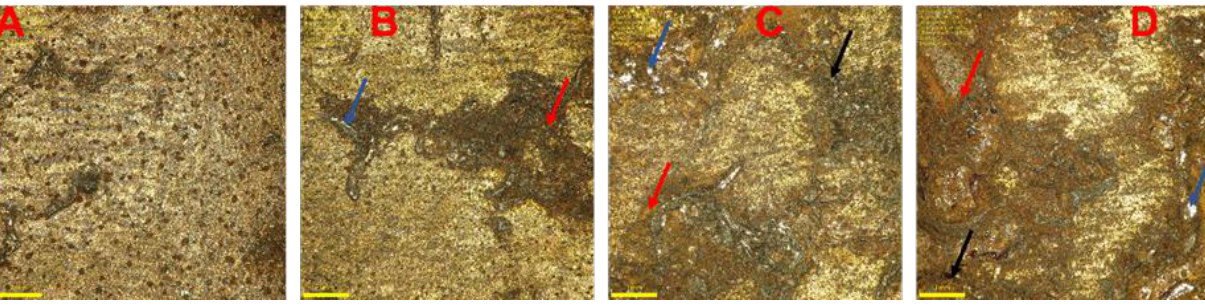
Figure 16. The corroded surface of sample S2 (4% AgNp + CaCO 3 ) in 0.10 HCl. ( A ) 3 days ( B ) 12 days ( C ) 21 days and ( D ) 30 days.